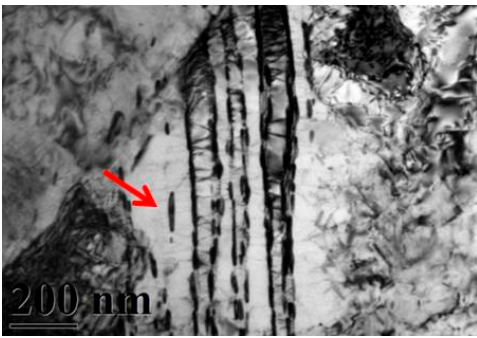
Figure 7. Bright ‐ field TEM image of the specimen aged at 550 °C for 1 h (Sample E).